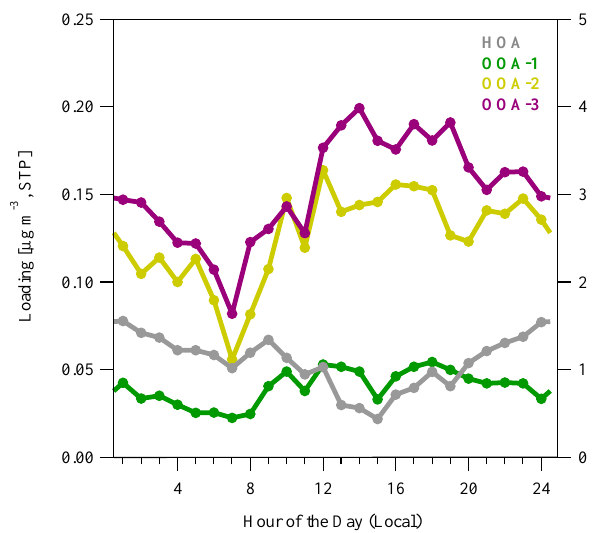
Figure 8. Campaign-average diel profiles of the loadings of the fac- tors HOA, OOA-1, OOA-2, and